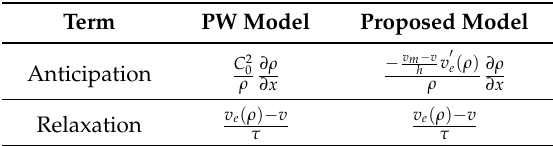
Table 1. Payne–Whitham (PW) and proposed model